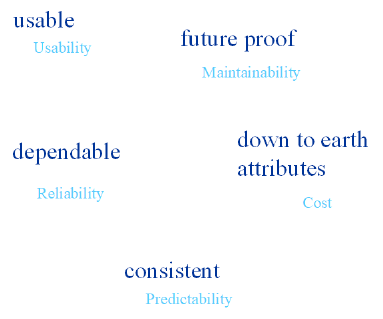
Figure 7. Qualities model.